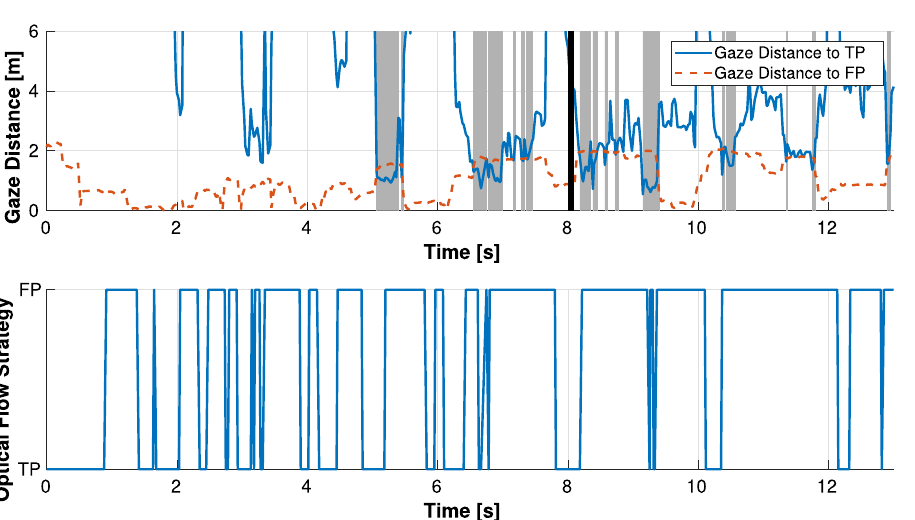
Figure 13. Result in straight situation. The top figure shows the gaze distance to TP/FP of the observed driver behavior. The gray zone means the TP fixation strategy, while the black line is the boundary between the straight and curved sections. The bottom figure shows the calculated gaze strategy based on optical flow theory. The result estimates either FP or TP fixation